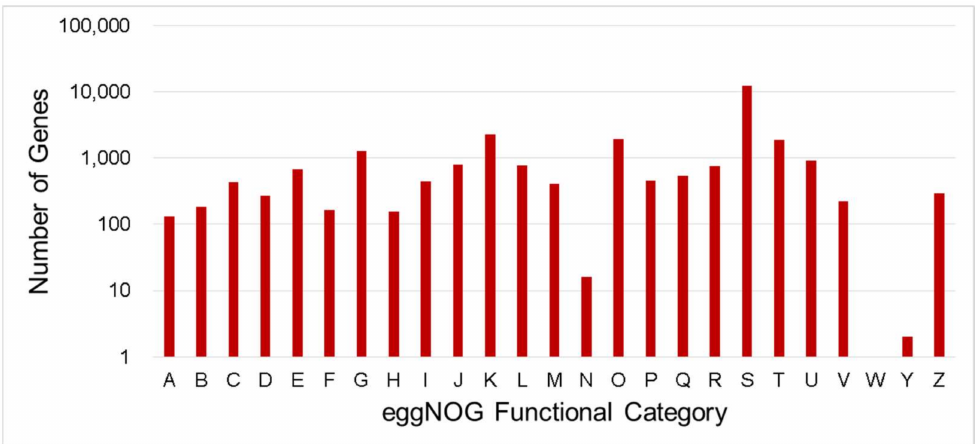
Figure 3. Number distribution of eggNOG annotation of Unigenes related to A–Z. A—RNA process- ing and modification; B—Chromatin structure and dynamics; C—Energy production and conver- sion; D—Cell cycle control, cell division, chromosome partitioning; E—Amino acid transport and metabolism; F—Nucleotide transport and metabolism; G—Carbohydrate transport and